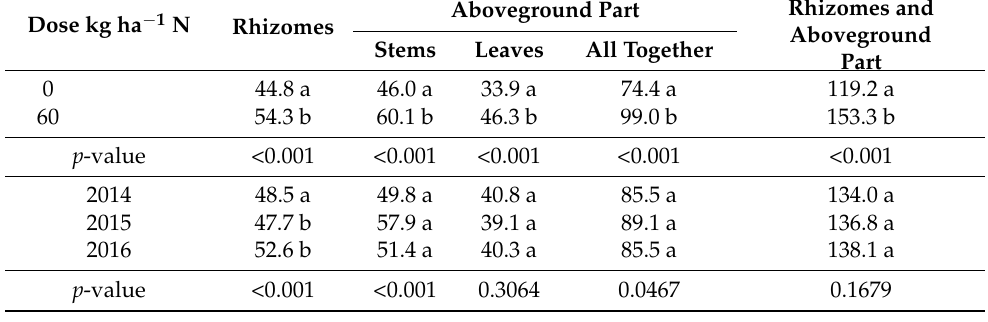
Table 2. Crude ash uptake by g · m − 2 (average for 2014–2016).